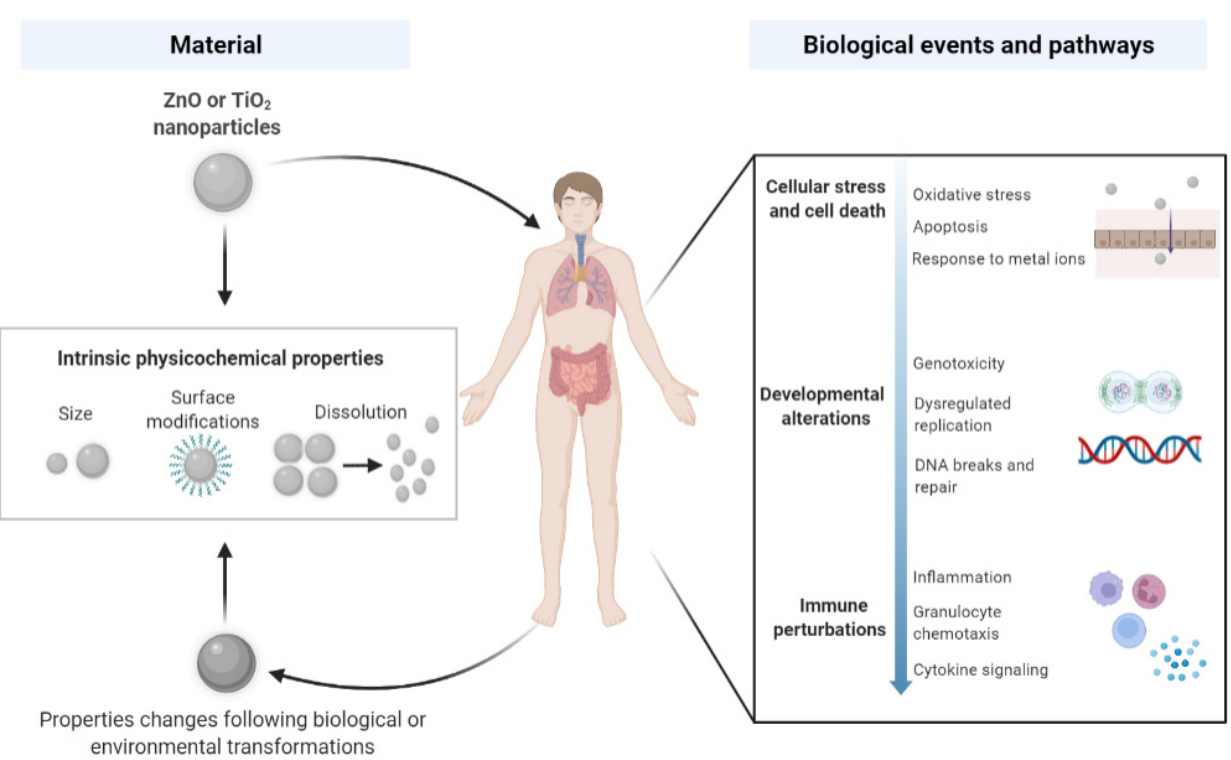
Figure 1. Interactions of ZnO and TiO 2 nanoparticles with biological systems. Upon human-relevant exposures via ingestion, dermal contact and inhalation, ZnO and TiO 2 NPs with acquired and/or transformed physicochemical identities, together with material-intrinsic properties, are able to induce various biological processes and pathways. Adapted from “Nanoparticle Interactions with Biological Systems and Vice Versa”, by BioRender.com (2022). Retrieved from https://app.biorender.com/ biorender-templates, accessed 25 March 2022.